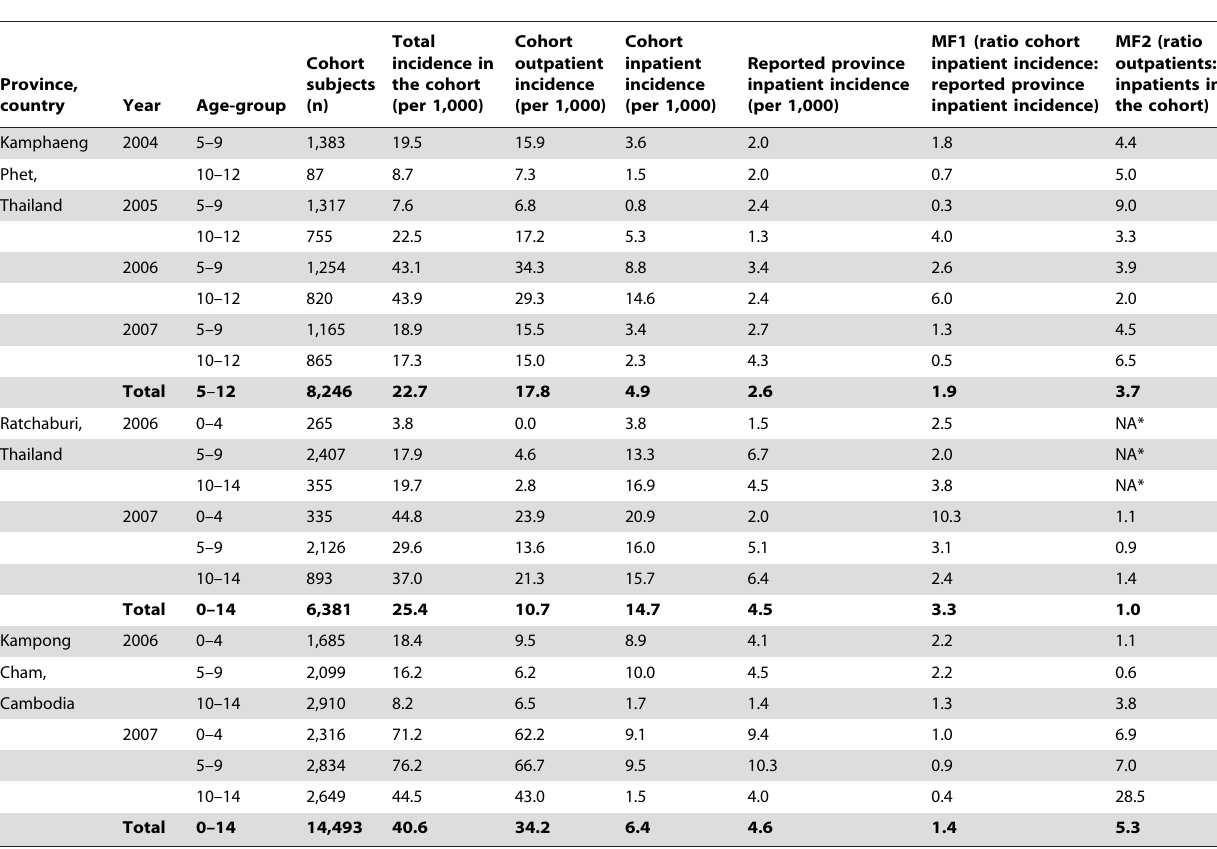
Table 1. Age-group specific dengue incidence in three cohort studies and reported provincial incidence by year.